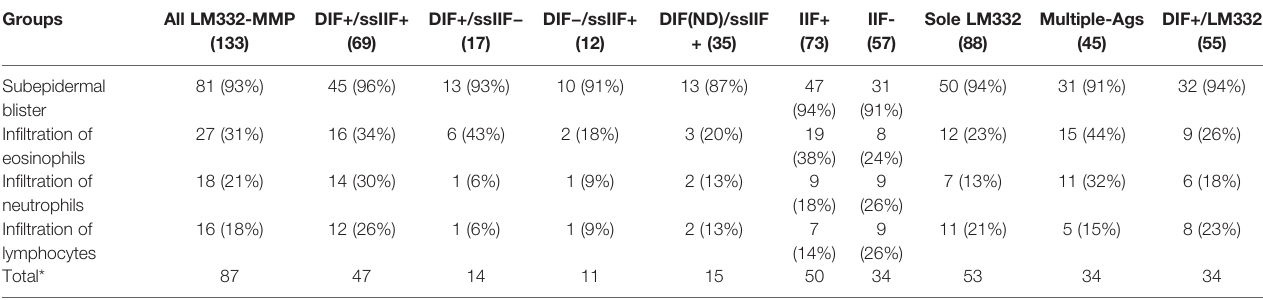
TABLE 2 | Histopathological fi ndings in the 133 patients with anti-laminin (LM) 332-type mucous membrane pemphigoid (MMP).